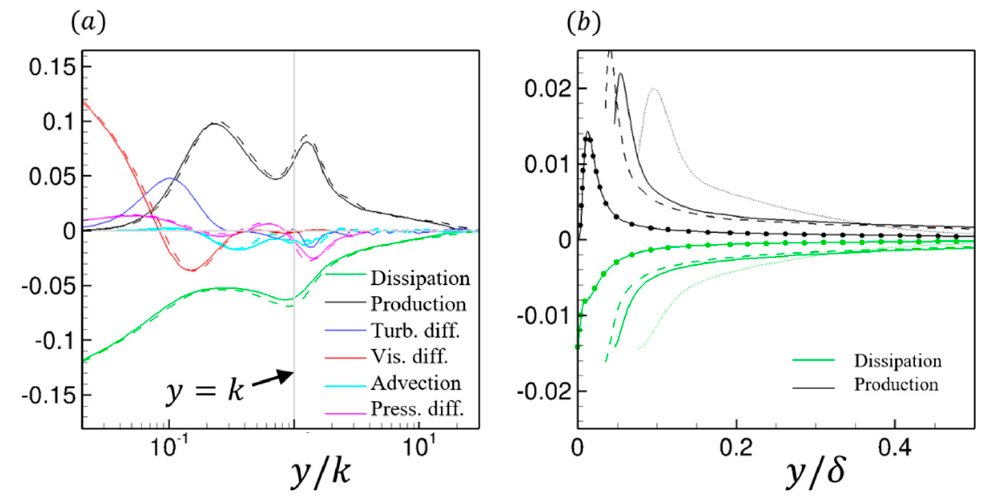
Figure 15. ( a ) Wall-normal variation of inner-scaled (normalization by u 4 τ / ν ) TKE budget terms inside and immediately above the canopy at x = 405 θ 0 (solid lines) and x = 650 θ 0 (dashed lines) for case R . ( b ) Wall-normal variation of outer-scaled (normalization by U 3 ∞ / δ ) TKE production P and TKE dissipation (cid:101) in the outer layer at x = 100 θ 0 (dotted lines), x = 405 θ 0 (solid lines), and x = 650 θ 0 (dashed lines) for case R and at x = 715 θ 0 (solid lines with filled symbols) for case S . Only data from above the canopy ( y > k ) are presented for case R in ( b ). Profiles in ( a , b ) are extracted from the spanwise center of a repeating unit.